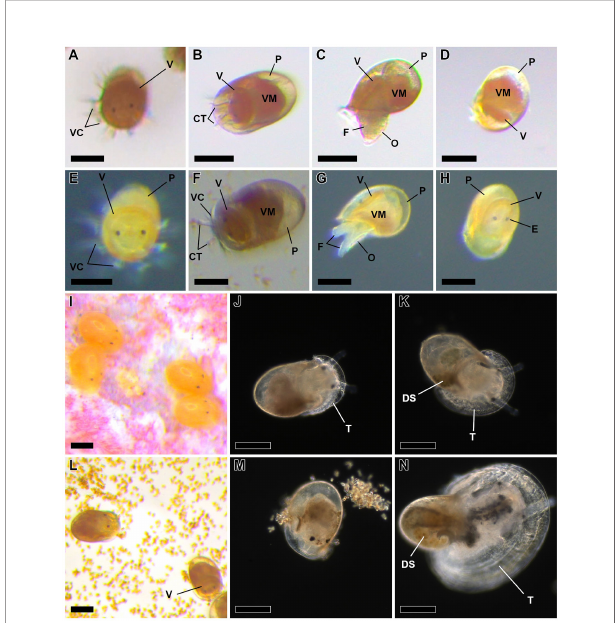
FIGURE 10 | Settlement and metamorphosis in the limpet species P . aspera and P . candei . Key characters for the identi fi cation of the pediveligers and typical behaviors of this stage (A – H) . P. aspera 4 days post-fertilization (A – D) : swimming (A) , crawling (B) , withdraw (C) , and resting (D) . P. candei 6 days post-fertilization (E – H) : swimming (E) , crawling (F) , withdraw (G) , and resting (H) . Comparison between the pediveliger and the post-larval stages (I – N) . P . aspera (I – K) : group of early post-larvae settled on encrusting coralline algae, 7 days post-fertilization (I) ; early post-larvae, 8 days post-fertilization (J) ; juvenile, 15 days post-fertilization (K) . P . candei (L – N) : early post-larvae (left) and crawling pediveliger (right) on Navicula incerta bio fi lm, 7 days post-fertilization (L) ; early post-larvae, 39 days post-fertilization (M) ; juvenile, 39 days post-fertilization (N) . Scale bar = 100 µm. CT, cephalic tentacle; DS, digestive system; E, eyespot; F, foot; O, operculum;